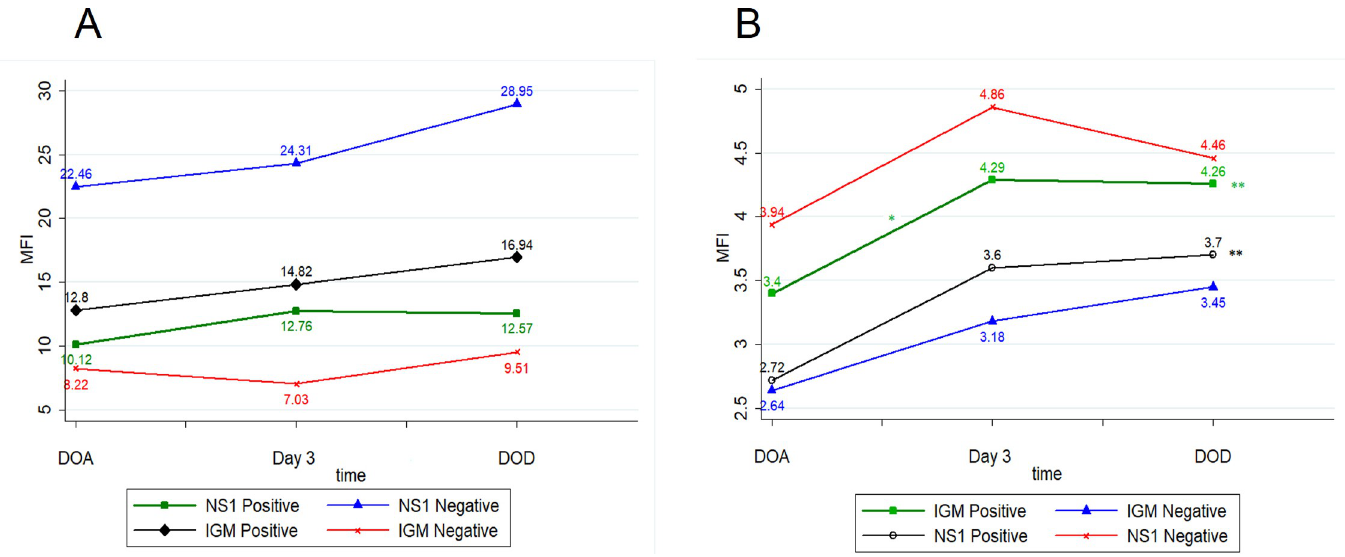
Fig 3. Line graph among NS1 and IGM groups (A) DC-SIGN (CD209) (B) FC U R2A (CD32). (DOA- Day of Admission, DOD- Day of Discharge) � Comparison between two time points, indicates p value < 0.05 �� Comparison across all three time points, indicates p value < 0.05.